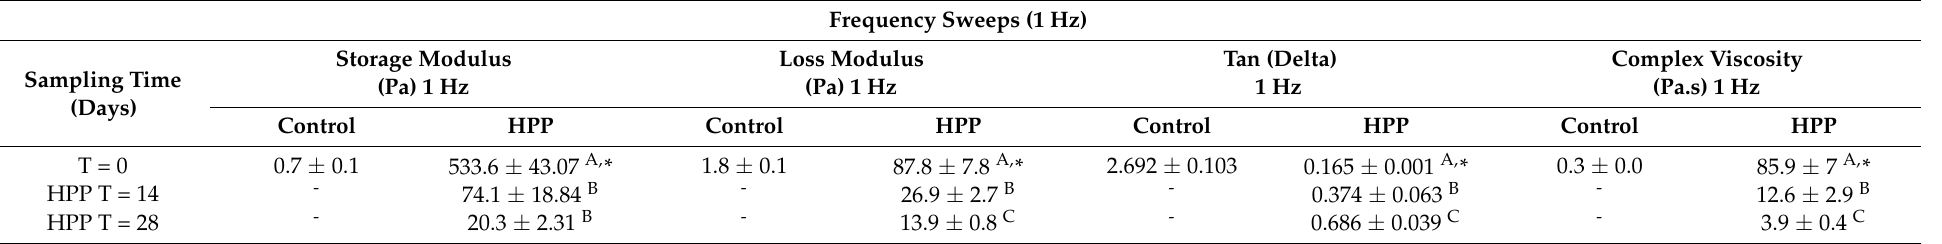
Table 2. Viscoelastic parameters were obtained from frequency sweep tests at 1Hz (Storage modulus, loss modulus, loss tangent and complex